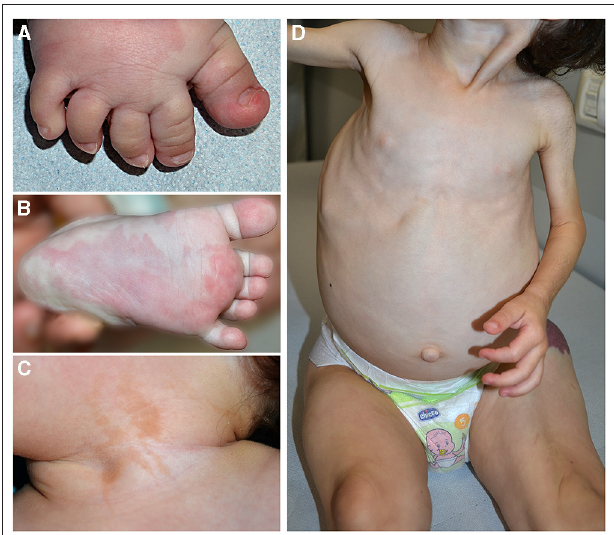
FIGURE 2 | Pseudosyndactyly (A) , sandal gap, and capillary malformation in a patient with PIK3CA-related overgrowth syndrome (A) . Triangular shape of the left foot (B) and epidermal nevus of the neck in the same patient (C) . Plus/minus sign, overgrowth of lower limbs in contrast with upper limbs hypoplasia in a child affected with CLOVES (D) .